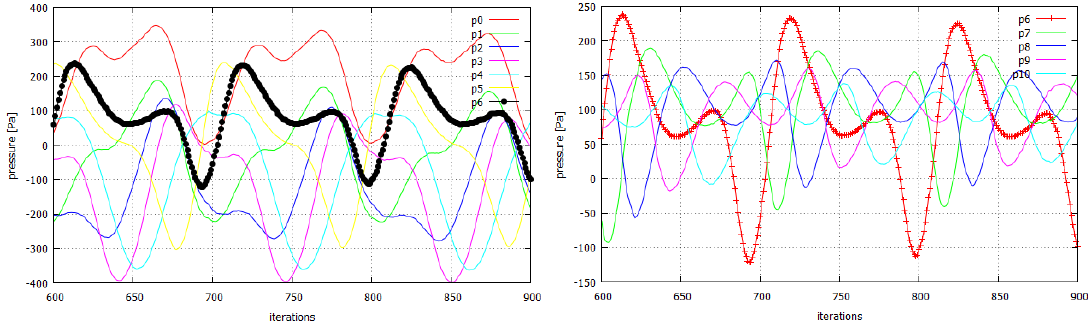
Figure 12: Pressure evolution for case F2 along the diaphragm at points p0,...p6 (left) and p6,...p10 (right).